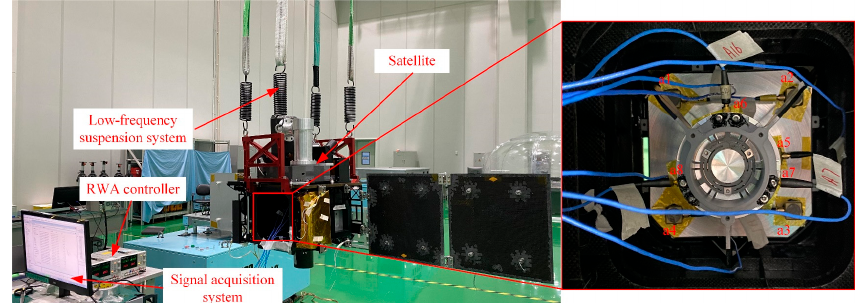
Figure 7. Test platform for the microvibration.